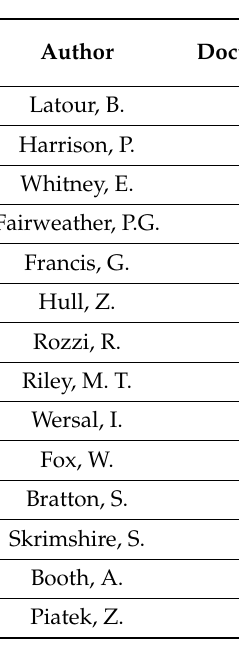
Table 3. Top authors by